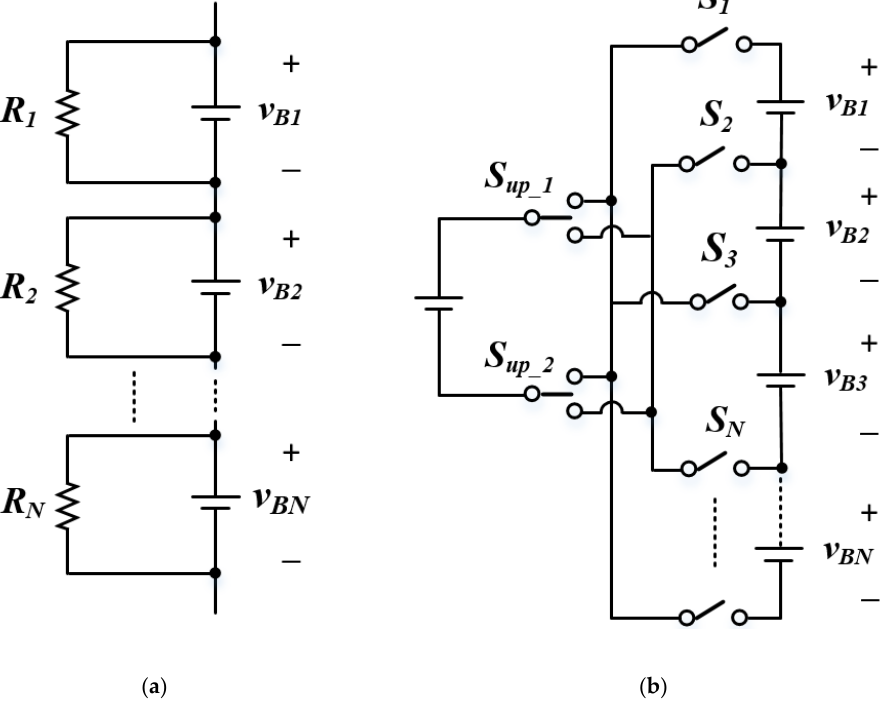
Figure 1. Conventional cell balancing methods. ( a ) passive method; ( b ) active method